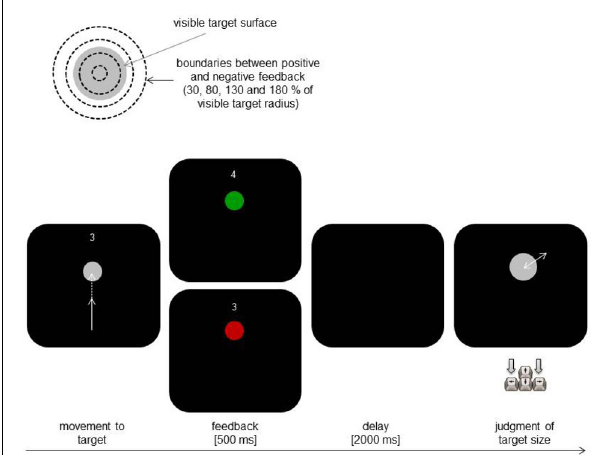
FIGURE 1 | Schematic illustration of the critical manipulation (upper part) and of the main trial events in Experiment 1 (lower